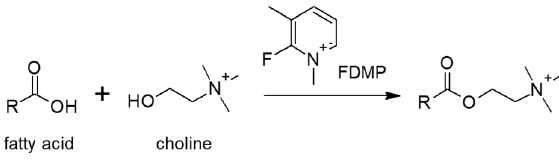
Figure 3. The LOD for palmitic acid was 50 ng/mL in hydrophilic interaction chromatography (HILIC)-ESI-MS [22].